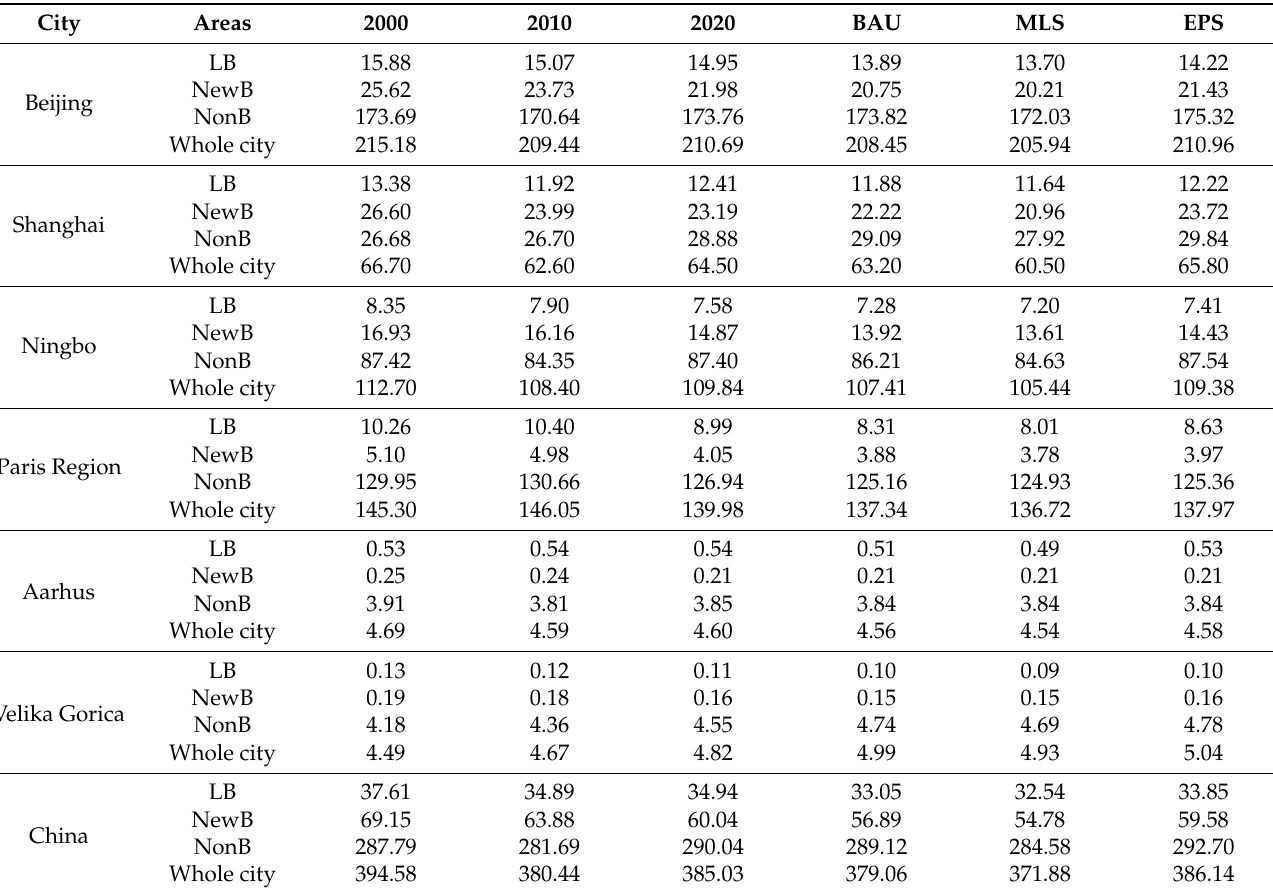
Table A6. Total carbon storage statistics for different areas of each city from 2000 to 2030. (Unit: